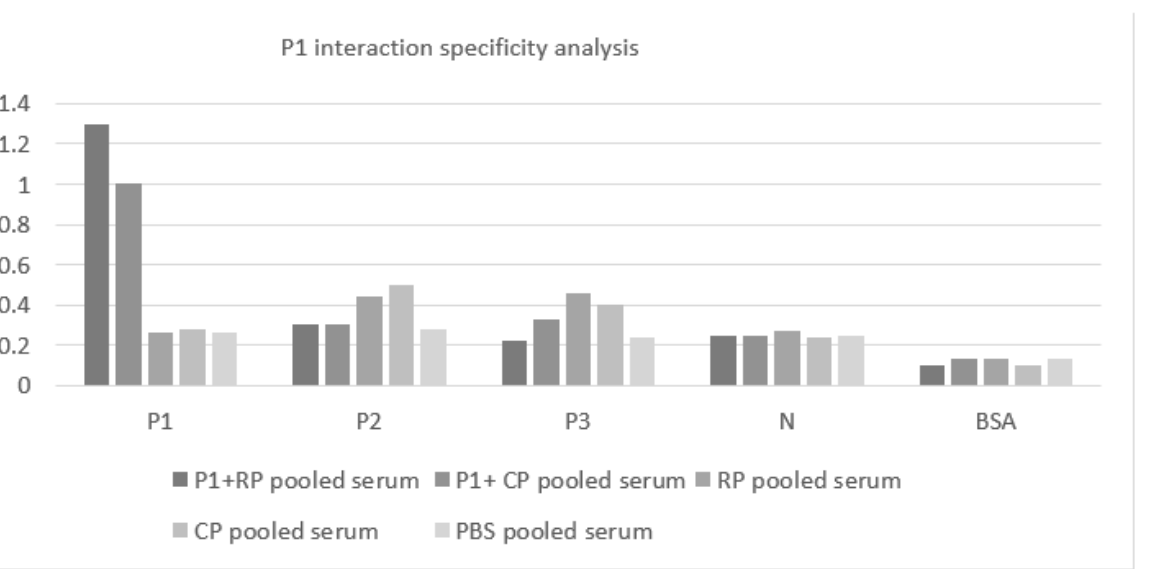
Figure 8. Immunization of mice against P1 protein: Anti-P1 antibodies increased in all mice immunized with P1+ recombinant/helper phage and in the group receiving P1 + Alum. There was a significant difference between the P1-receiving groups compared with the negative control groups (non-injected mice and PBS-inoculated group). Y -axis indicates optical density. Abbreviations: RP: P1 recombinant phage, CP: control phage, PBS: phosphate buffer saline, NI: non-injected. Moreover, the pooled sera of P1+ recombinant/helper phages specifically interacted with P1 compared with other nonspecific proteins, i.e., P2, P3, N, and BSA (Figure 9).